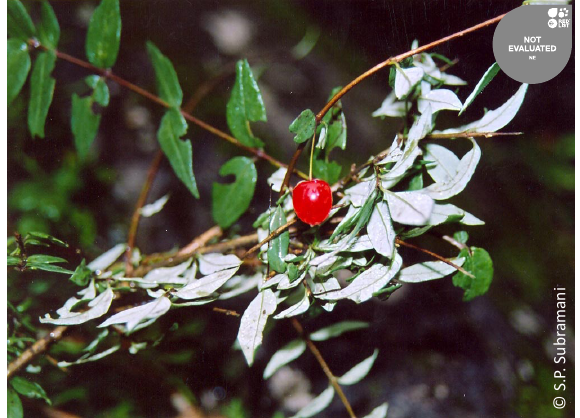
Image 7. Lonicera angustifolia Wall. ex DC.